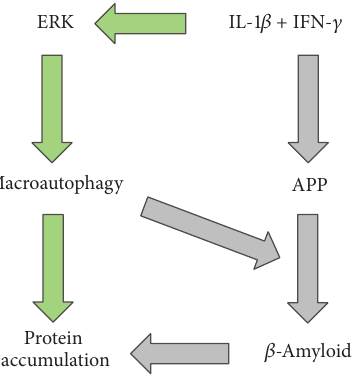
Figure 5: Model of regulation of macroautophagy in skeletal muscle via IL-1 𝛽 + IFN- 𝛾 and ERK. Green arrows depict findings of the present manuscript: IL-1 𝛽 + IFN- 𝛾 activates the ERK pathway. Phosphorylated ERK contributes to an upregulation of autolyso- somal turnover, which is followed by accumulation of protein. Previouslyknownpathwaysaremarkedbygreyarrows,includingan upregulation of APP upon exposure to IFN- 𝛾 + IL-1 𝛽 and followed by generation of 𝛽 -amyloid and accumulation of protein. It is known that macroautophagy contributes to production of 𝛽